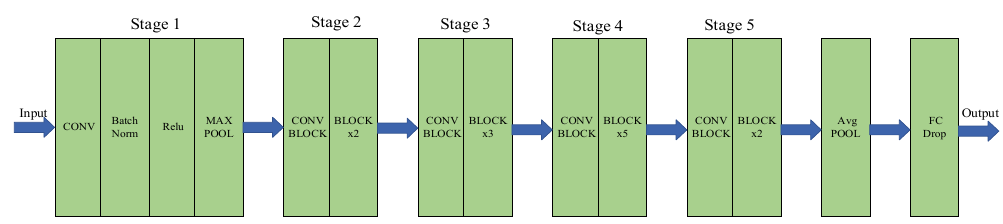
Figure 2. The architecture of the ResNet50 network.